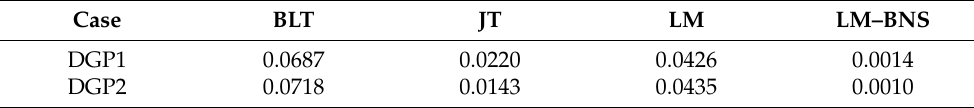
Table 3. Empirical sizes of co-jump tests under continuous processes *.